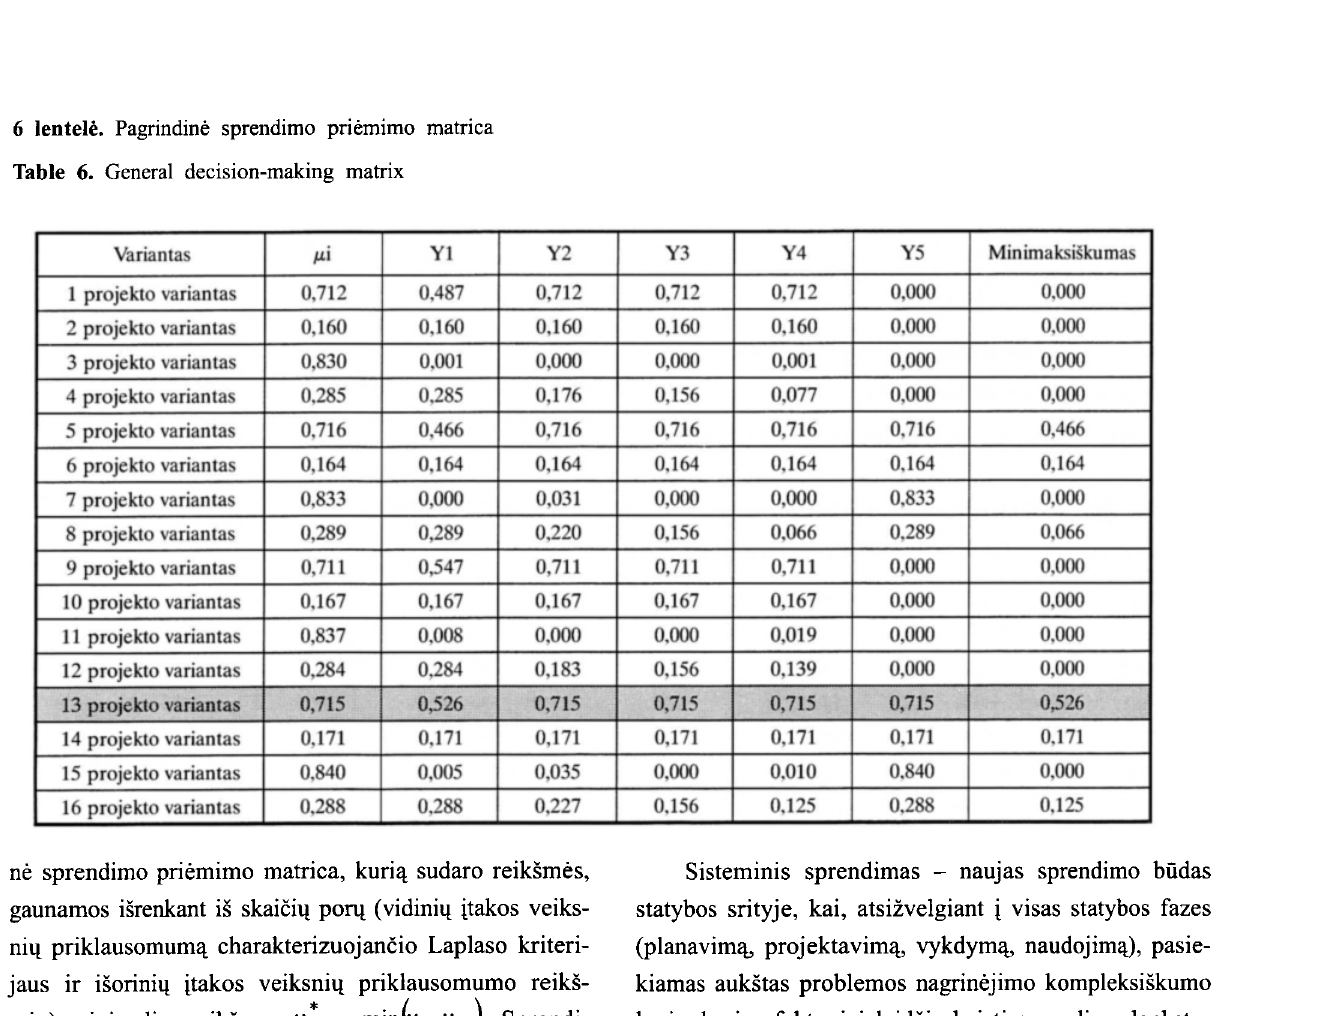
Table 6. General decision-making